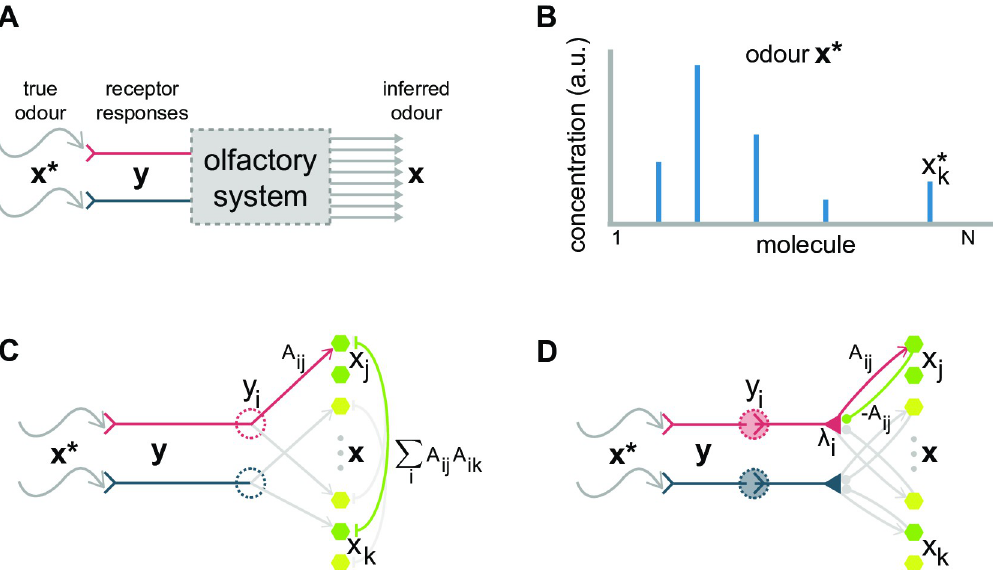
Fig 1. Olfaction as MAP inference. (A) Animals observe odours x � indirectly via receptor activations. We assume the function of the olfactory system is to report the odour x most likely to have caused the observed receptor activations y . (B) Schematic representation of an odour, whose defining feature is that it’s sparse (meaning very few components are active). (C) A basic circuit for performing MAP inference on odours: Receptor i projects directly to each readout unit x by the affinity of receptor i for molecule j ; the readout unit x j reciprocally inhibits unit x k with weight ∑ i A ij A ik . The latter term is likely be non-zero even if A is sparse (since that requires only one term in the sum over i to be nonzero), resulting in each ij readout unit inhibiting and being inhibited by potentially * 100,000 other units. (D) An alternate circuit that performs the same inference. Mitral cells now mediate between glomeruli and the readout units. Each mitral cell λ weight A and is in turn inhibited by the same amount. No inhibition is needed between readout units, but a mitral cell must ij still excite and be inhibited by each of potentially * 100,000 readout units.